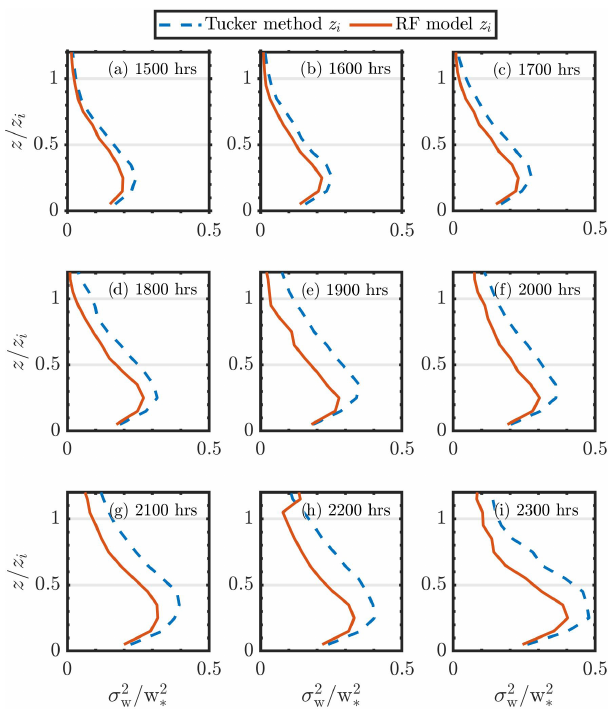
Figure 10. Average normalized vertical velocity variance profiles during convection periods (15:00 to 23:00UTC, a–i ) at SGP from 2015 to 2019 versus non-dimensional height using z i estimated by the Tucker method and RF model. Appropriate z i (RF model or Tucker method) was used in both x - and y -axis